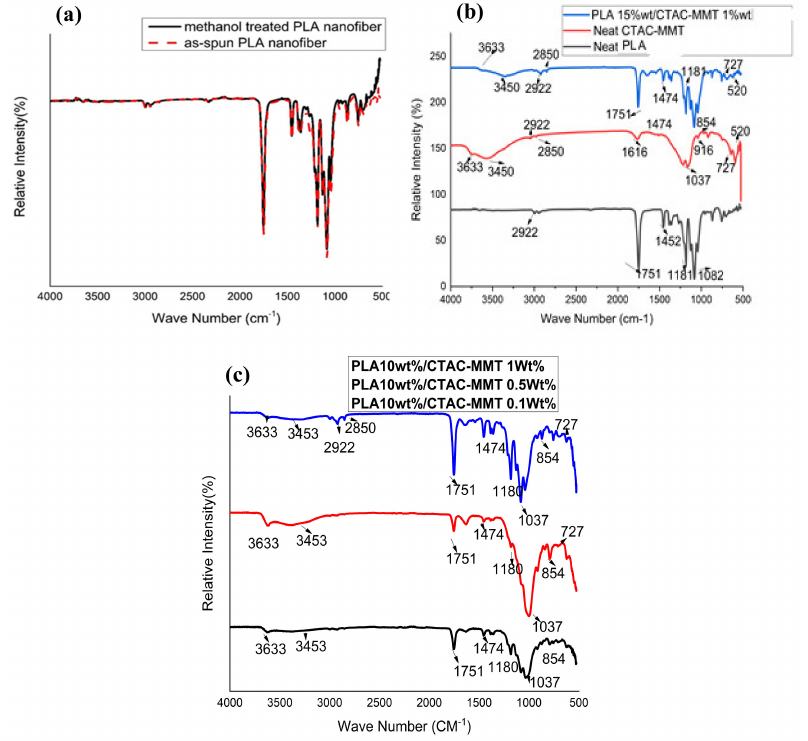
Figure 5. FT-IR spectra of the methanol treated PLA nanofiber (solid line) as-spun PLA nanofiber ( a ); ( b ) Neat electrospun PLA nanofiber (Black), Neat CTAC-MMT (Red) and PLA / CTAC-MMT nanocomposite (Blue), ( c ) PLA / CTAC-MMT fibers ( b ); (CTAC-MMT 1% / PLA 10% (blue), CTAC-MMT 0.5% / PLA (red), 10% CTAC-MMT 1% / PLA 10% (black)) ( c